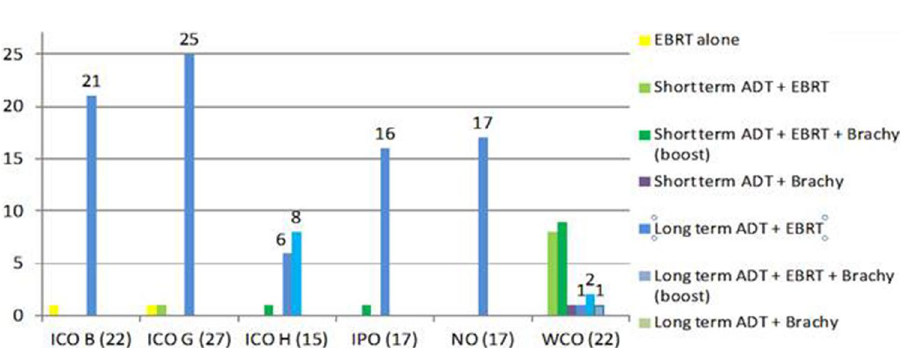
Figure 3. Treatment administered in high risk patients and number of patients per treatment